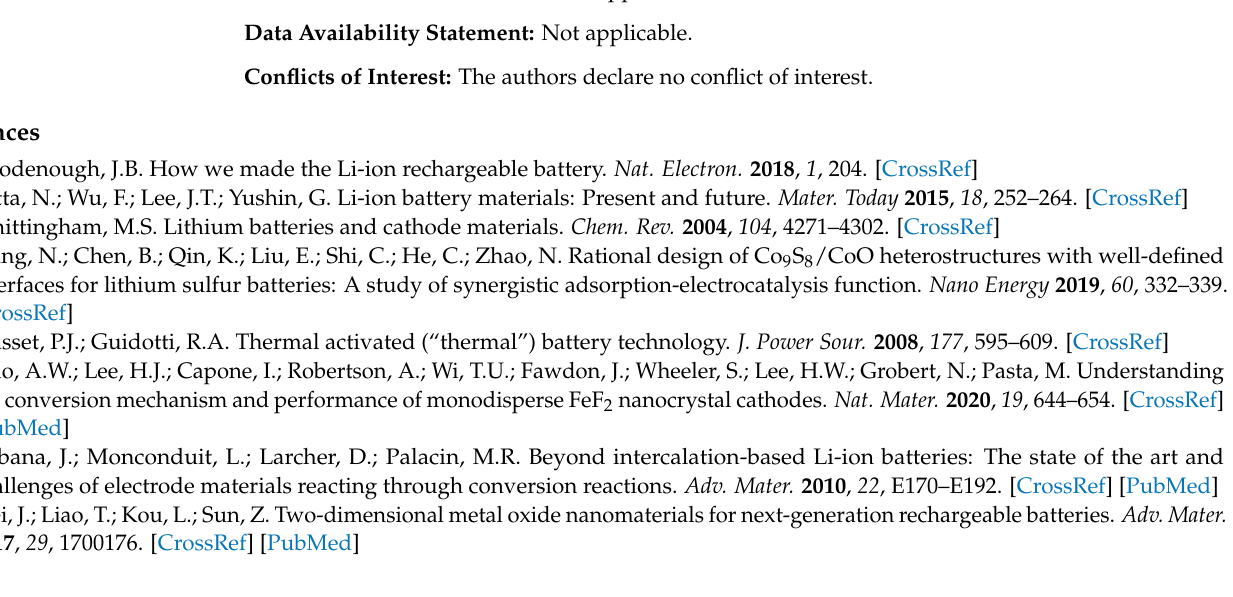
patterns of Cr 8 O 21 electrodes with different ALD cycles. Figure S6: XPS spectra of Cr 8 O 21 electrodes. Figure S7: XPS spectra of Cr 2p with different coating cycle numbers (8, 12, 16). Figure S8: CV curves of PEO members at a scan rate of 0.1 mV s − 1 (60 ◦ C). Figure S9: Galvanostatic charge/discharge profiles of Cr 8 O 21 electrode with liquid electrolyte (1 M LiPF6 EC/DMC). Figure S10: The linear fits of the relationship between Z (cid:48) and ω − 0.5 of Cr 8 O 21 electrode with different ALD cycles (0, 8, 12, 16, 20). Figure S11: The partially enlarged spectra in the range of 1560 cm − 1 to 1720 cm − 1 . Figure S12: The partially enlarged spectra in the range of 3200 cm − 1 to 3600 cm − 1 . Figure S13: Electrochemical polarization voltage of Cr 8 O 21 electrode with different ALD cycles (0,